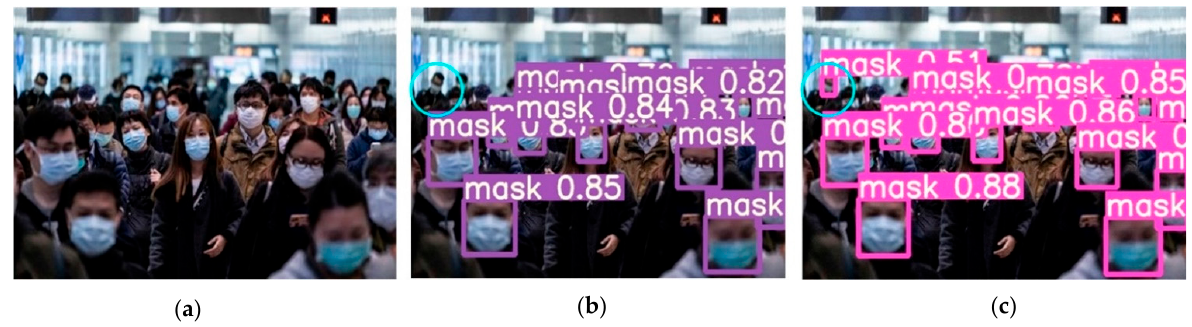
Figure 15. Detection of cross-dense targets. ( a ) Initial image sample; ( b ) YOLOv5 detect results; ( c ) YOLOv5-CBD detect results.